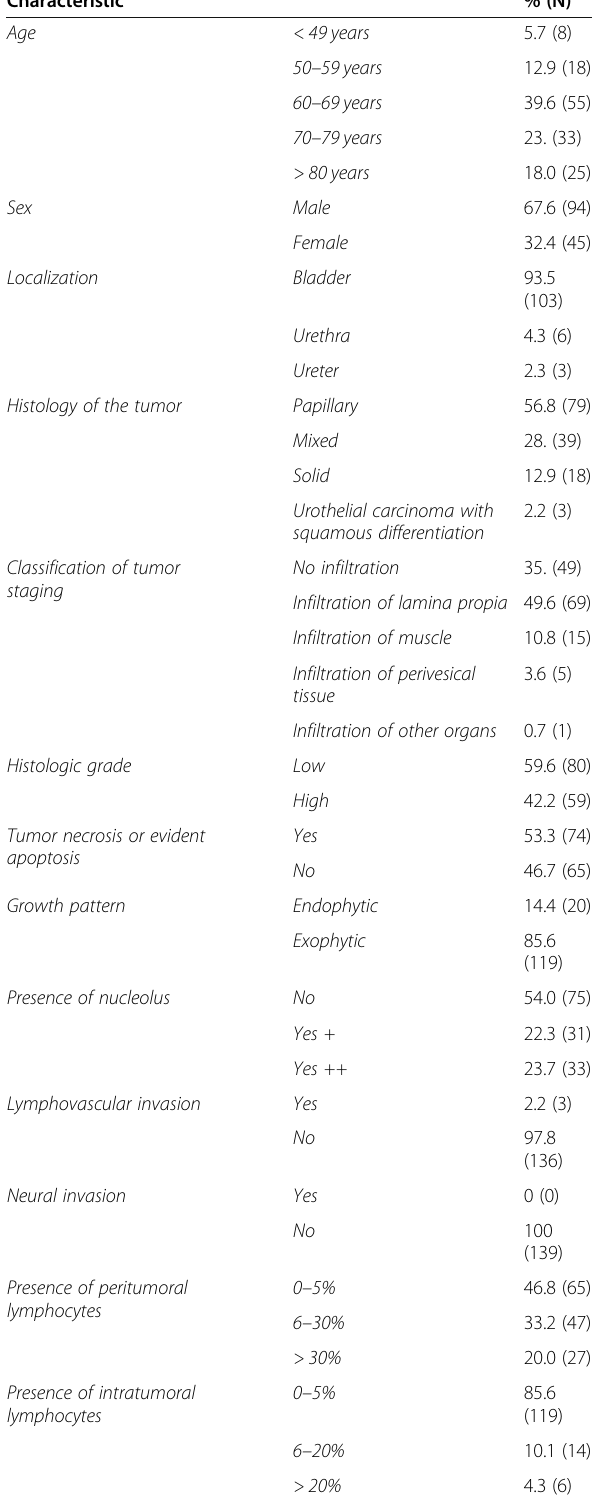
Table 2 Patient and tumor characteristics of 139 patients diagnosed with “ urothelial carcinoma